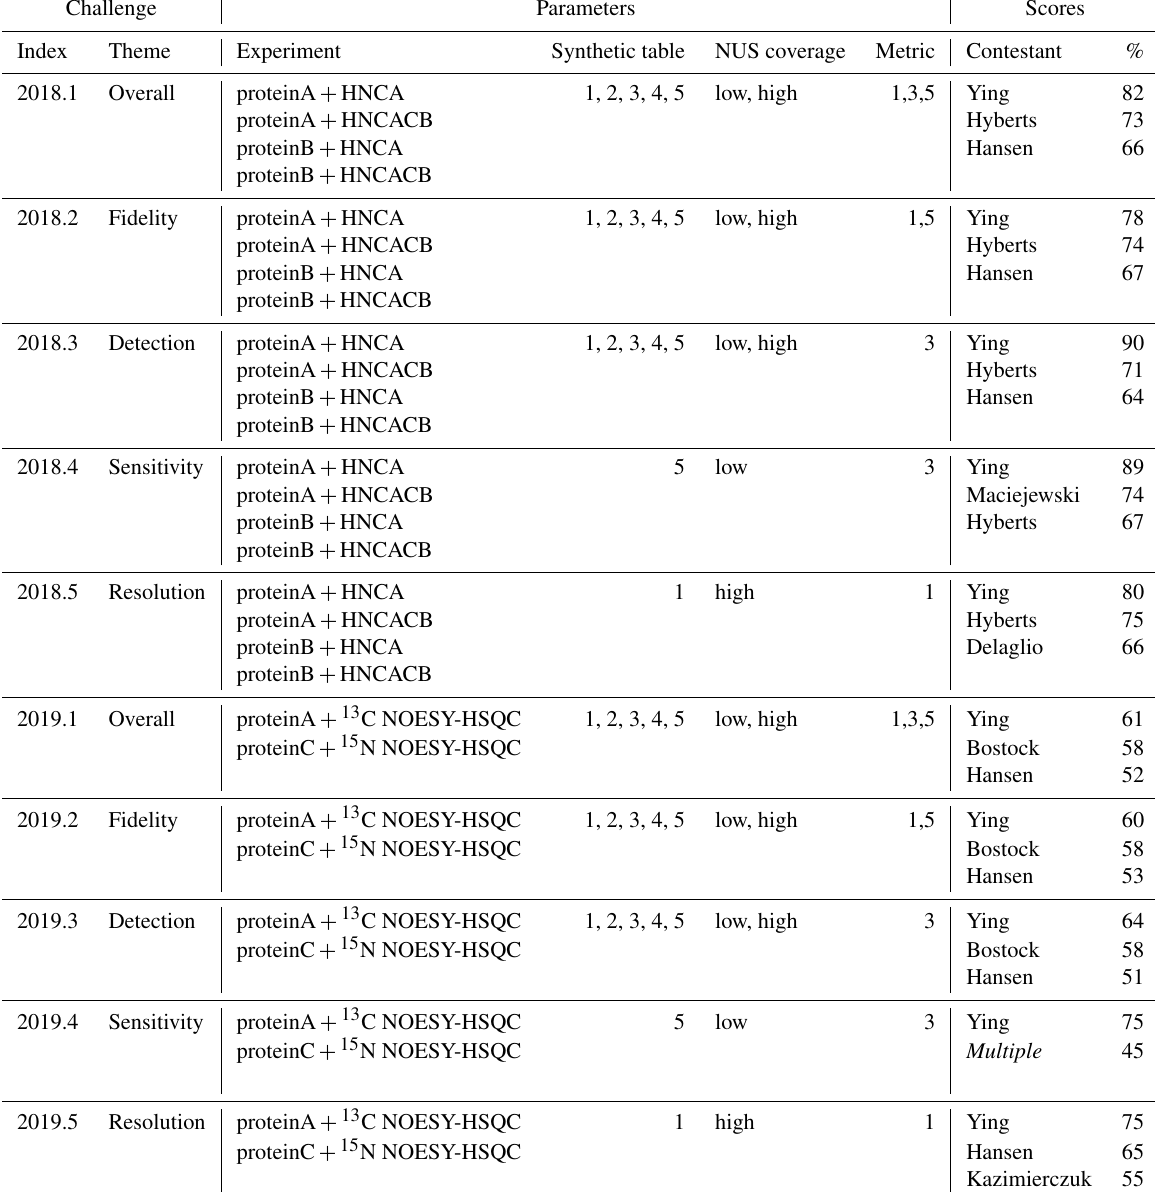
Table 4. NUScon challenges 2018/2019. Each row group (separated by horizontal lines) shows a NUScon challenge and the parameters that define it: “Experiment” defines the molecule and NMR experiment providing the uniformly sampled time-domain data. “Synthetic table” gives the index value(s) of the five synthetic peak tables that are generated for each experiment (see the Workflow discussion for information about the design of each). “NUS coverage” indicates the usage of the “low” and “high” coverage sample schedules generated for each experiment, as defined in Table 2. “Metric” lists the index value(s) of the metrics used to evaluate the reconstructions (see the Workflow discussion for information about each metric). The “Scores” column shows the top-performing contestants for the given challenge along with their average percentile taken across the evaluations of all parameter combinations that define the challenge. Note that not all contestants provided a submission for each challenge. The entry “ Multiple ” indicates a tie; complete results available in the NUScon